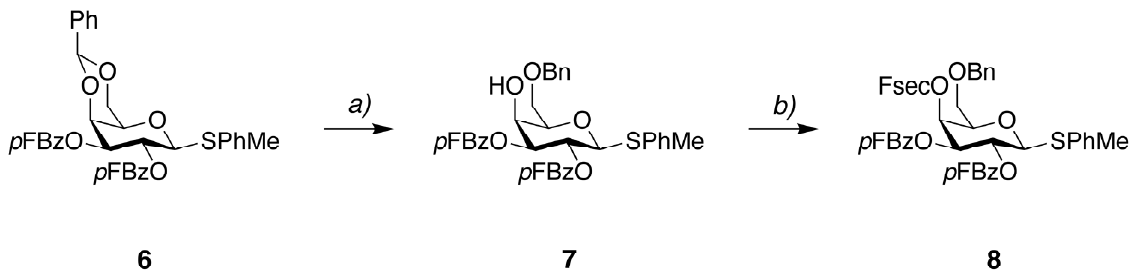
a Estimated from LC - UV